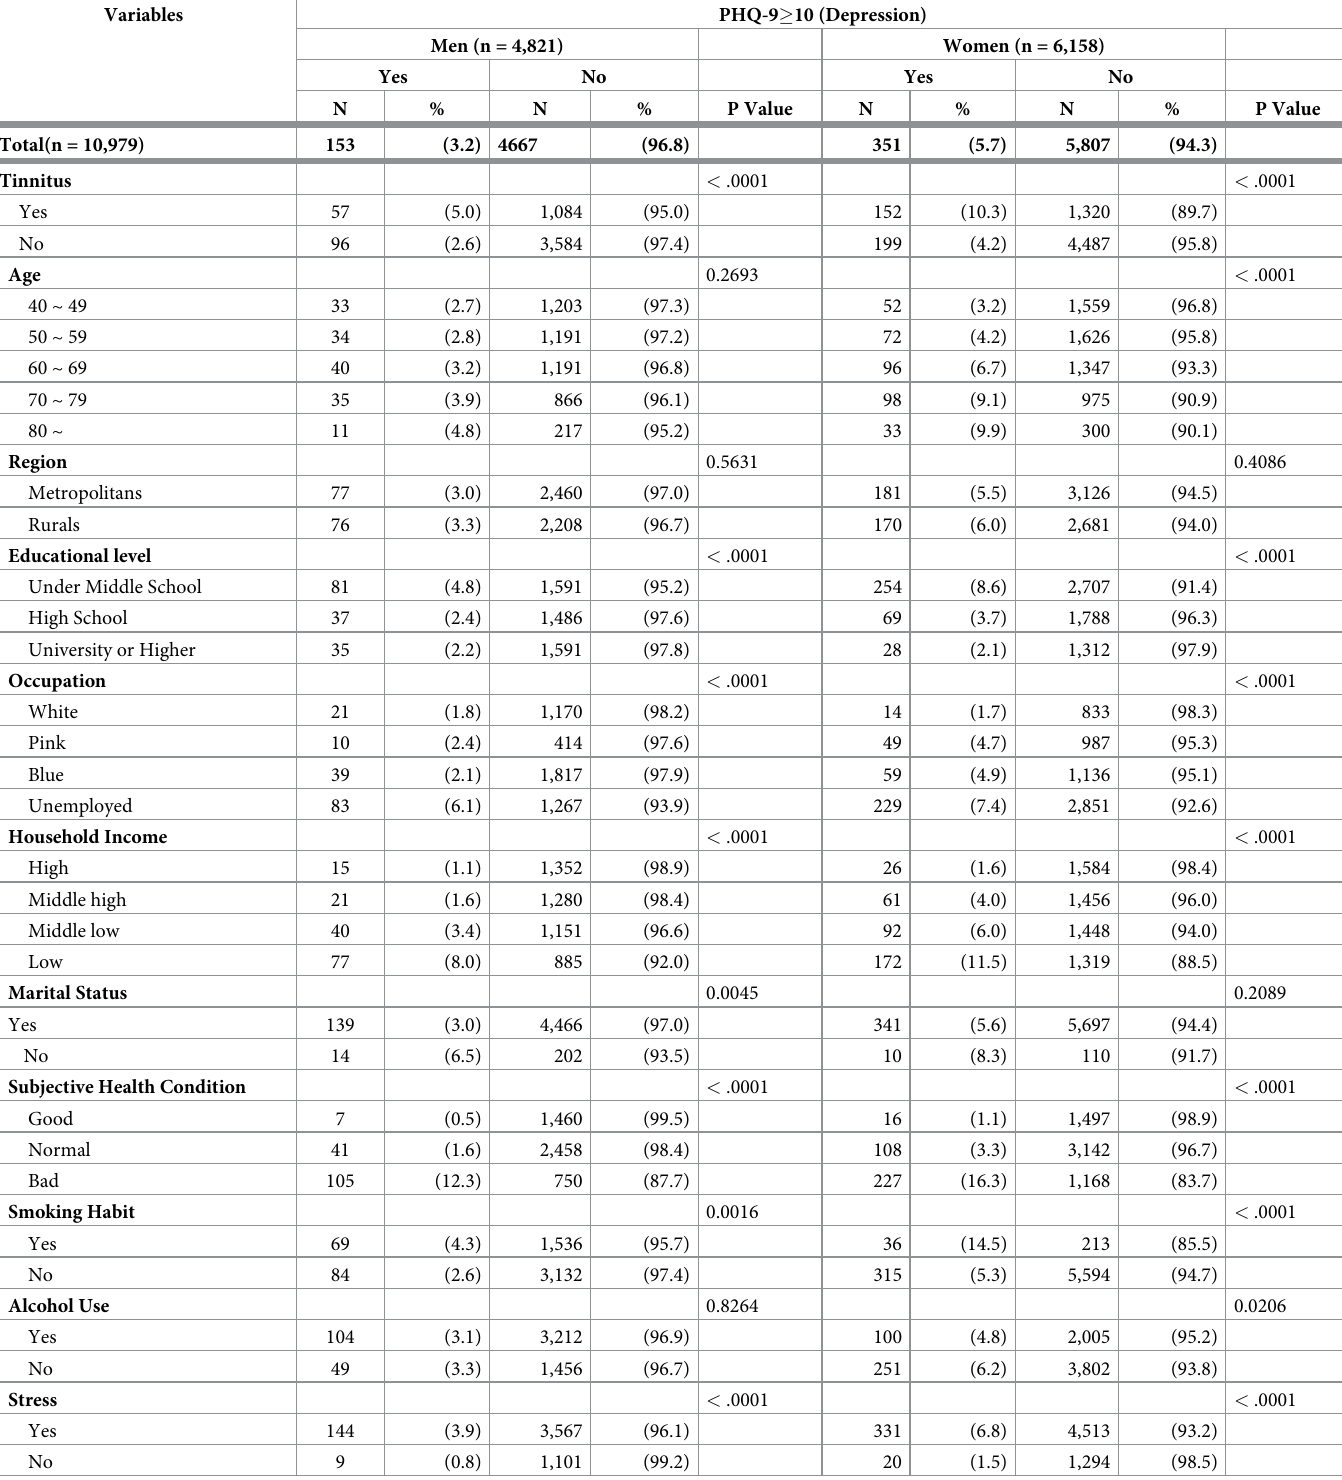
Table 1. General characteristics of the study